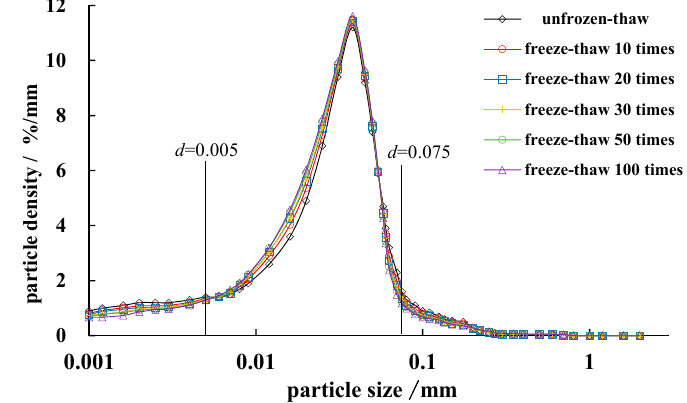
Figure 8. The particle bulk density curves of silt.